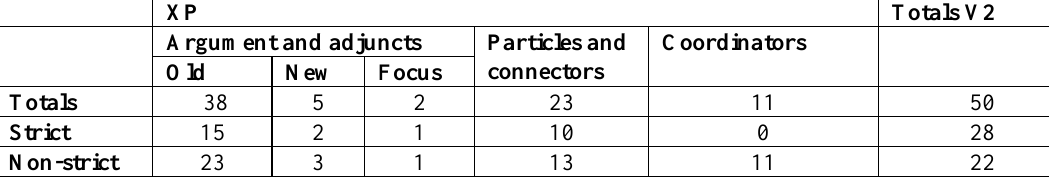
Table 1. Informational value of XPs in Year Book dialogue